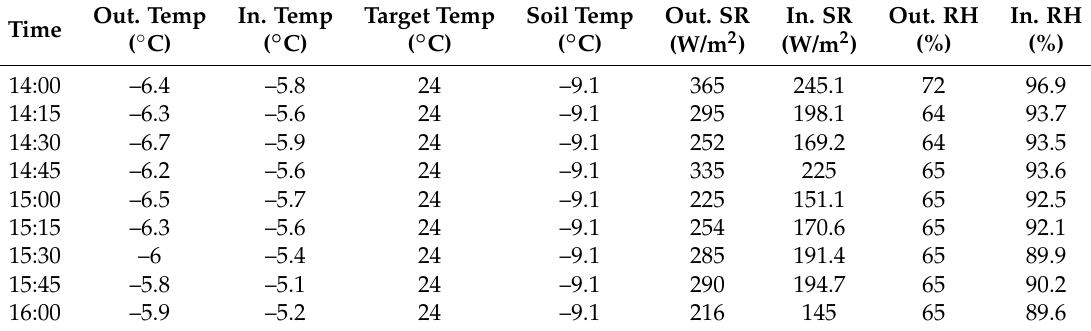
Table 9. Weather characteristics on one day in January (winter) tomato crop in Greenhouse 1.